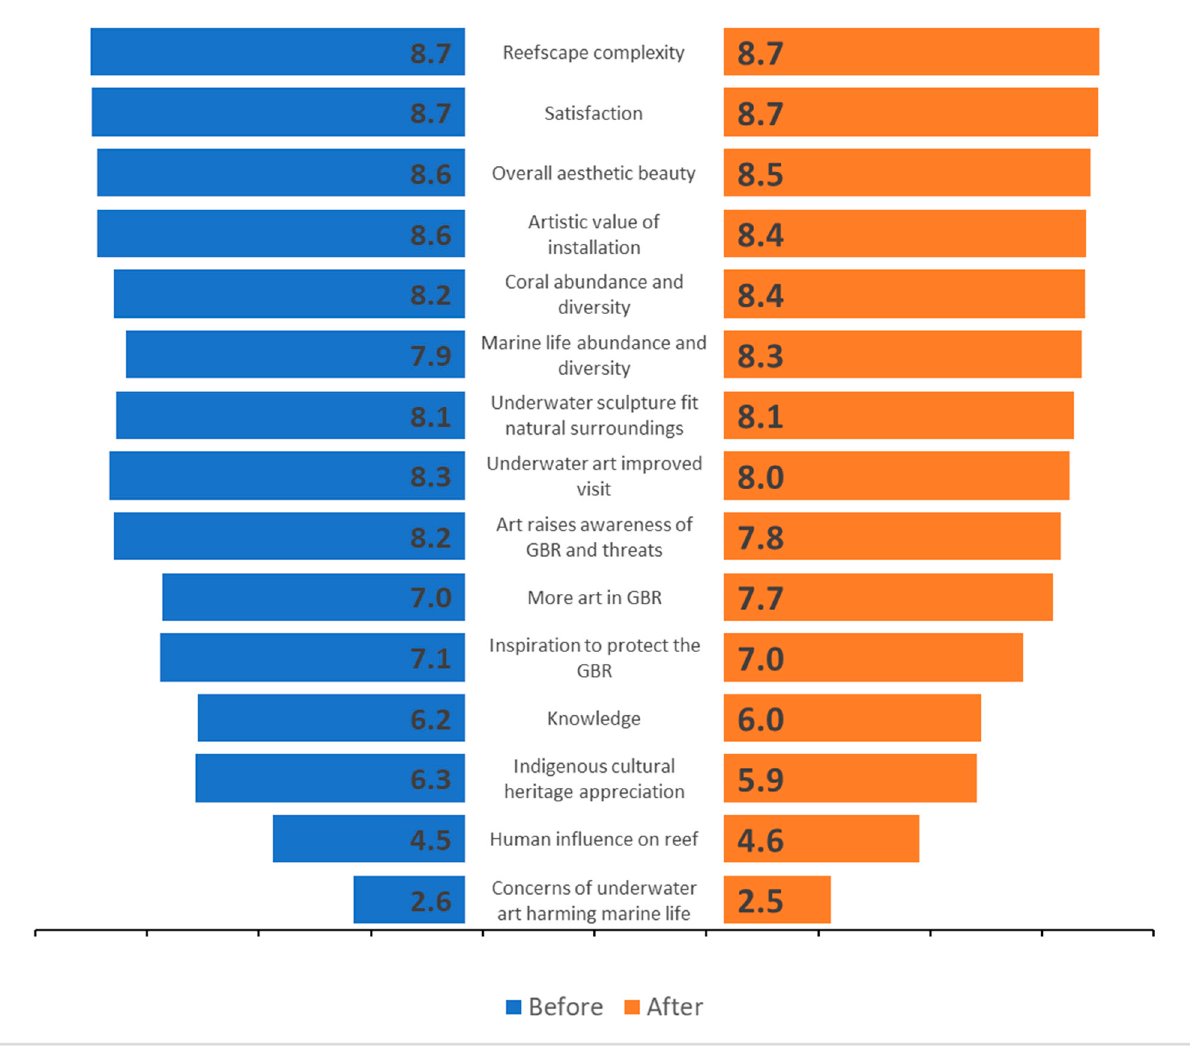
Figure 9. Average rating of agreement per statement: Before ( n = 142) (blue) and After ( n = 94) (orange) coral transplantation (14 March 2021).